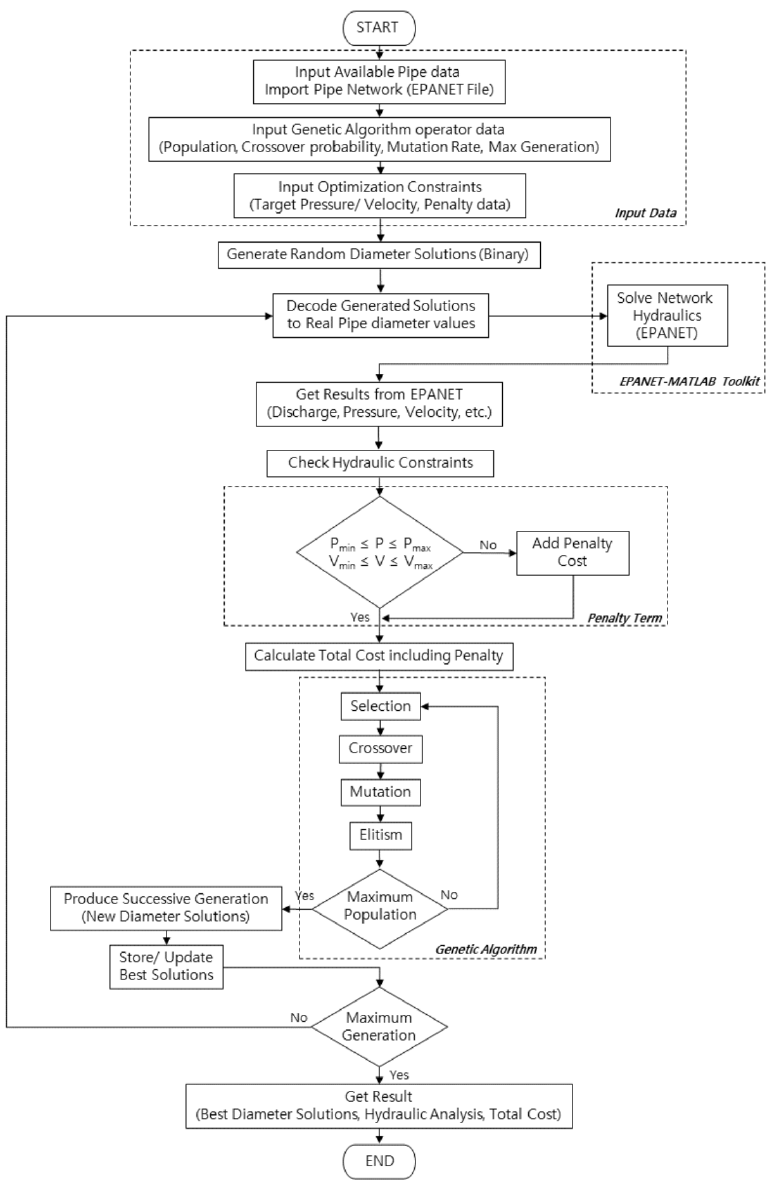
Figure 1. General Flowchart of the